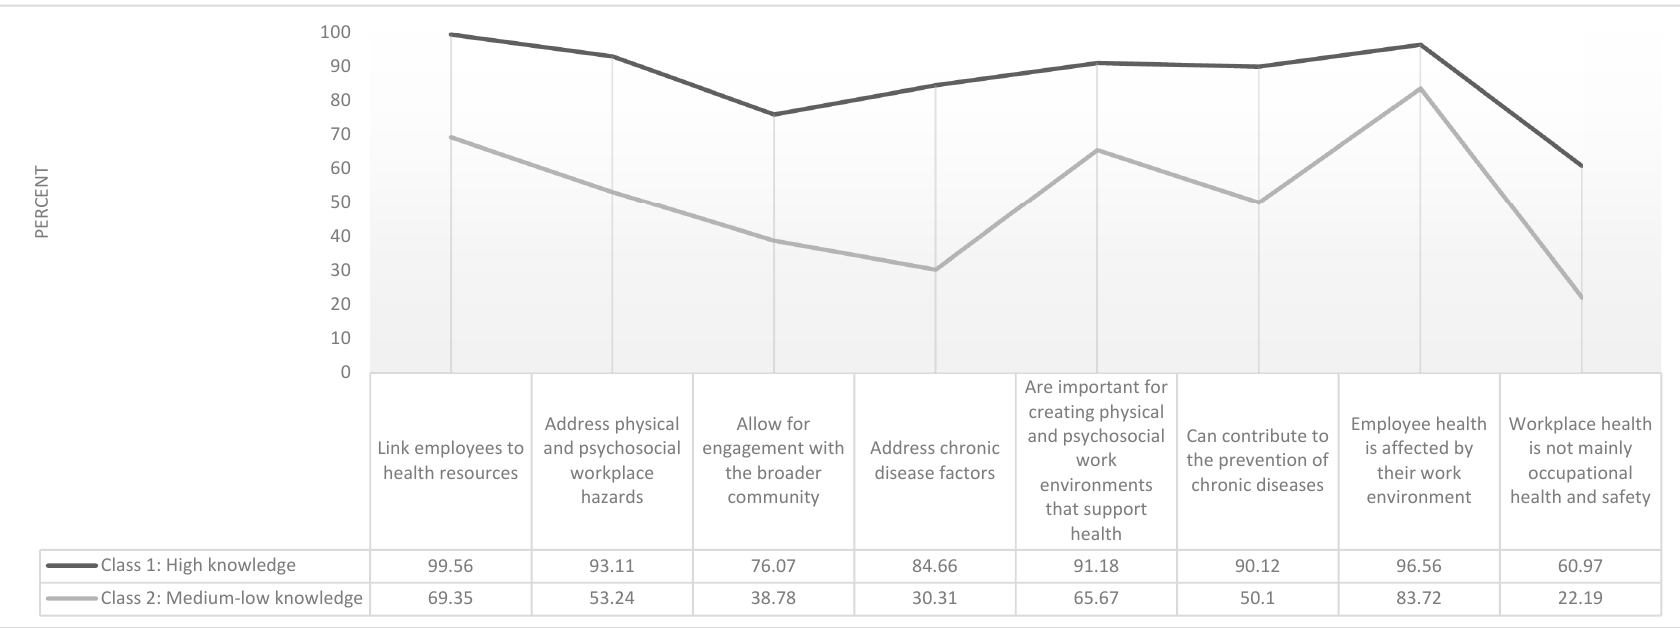
ffi rmative Response to Eight Workplace Health Program (WHP) Knowledge Items ( n = Figure 2. Percent Likelihood of Class Assignment Based on Affirmative Response to Eight Workplace Health Program (WHP) Knowledge Items (n = 528). Figure 2. Percent Likelihood of Class Assignment Based on A